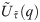
Potential energy profile U~τ~(q) at various τ~ values.Three characteristic regions are shown. Any potential curve at τ~>τ~c, τ~*<τ~<τ~c and τ~<τ~* lies in the domain denoted in red, yellow and green, respectively. Points q = qs and q = qc are points of maximum and minimum potential energy U~τ~(q), respectively. Bold lines correspond to potential energy curves for τ~=0, τ~=τ~*, and τ~=τ~с and are define as U~0(q), U~τ~*(q) and U~τ~с(q), respectively.